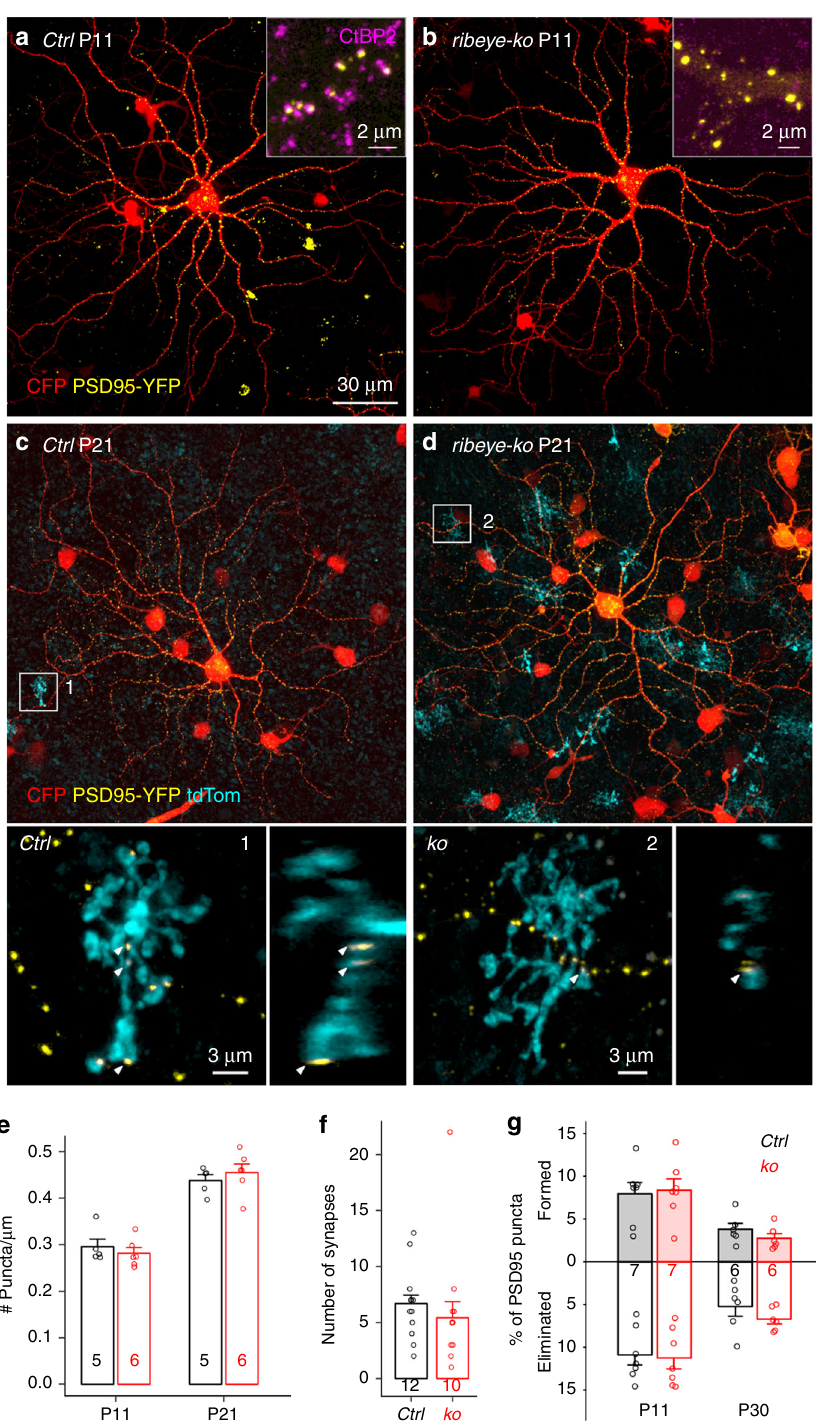
Fig. 6 PSD95 density is unperturbed in ribeye-ko mice. Visualization of PSD95 puncta on dendrites of ON-alpha RGCs in littermate control ( a ) and ribeye-ko ( b ) mice. Loss of ribbon apposed to PSD95 puncta was con fi rmed by CtBP2 immunostaining (A and B insets). Wholemount view of a ON-alpha RGC biolistically labeled in Grm6td-Tomato ctrl ( c ) or ribeye-ko ( d ) retina at P21. Magni fi ed views of a T6 BC synapsing onto the RGC in ctrl ( c , 1) or KO ( d , 2) retina are provided in the lower panels. Arrowheads indicate synapses between the T6 BC and the RGC. e Quanti fi cation of PSD95 density of ON-alpha RGCs in P11 and P21 retinas of littermate control ( ctrl ) and ribeye-ko (KO) mice. f Number of synapses between a pair of T6 BC and ON-alpha RGC. g Dynamics of PSD95 puncta on P11 ON-alpha RGCs during a 2 h recording period in ctrl and ribeye-ko mice. Number of cells is indicated in each bar graph. For each experiment, 2 – 4 retinas are used for each group. Data are presented as mean ±